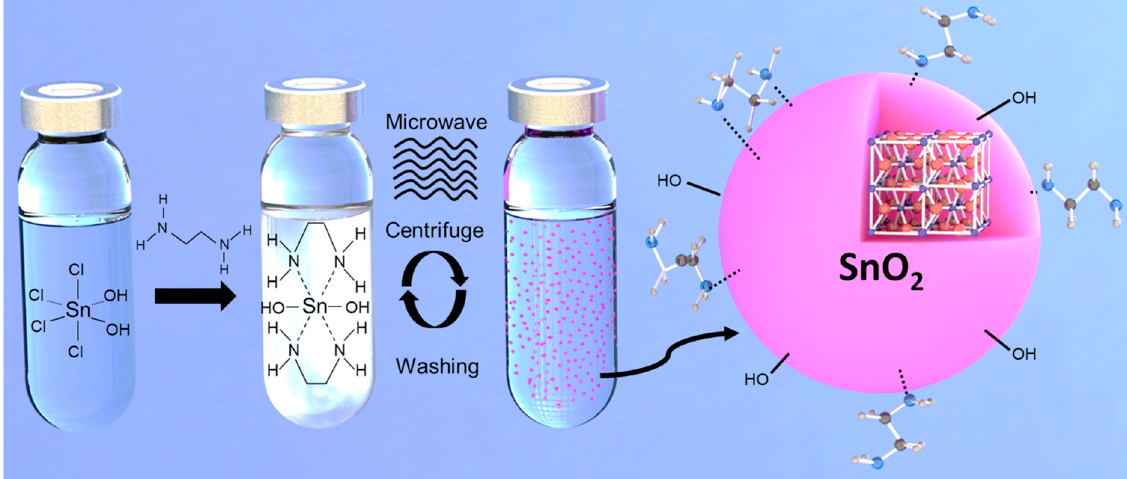
Figure 1. Schematic of microwave-assisted solvothermal synthesis of SnO 2 nanoparticles.